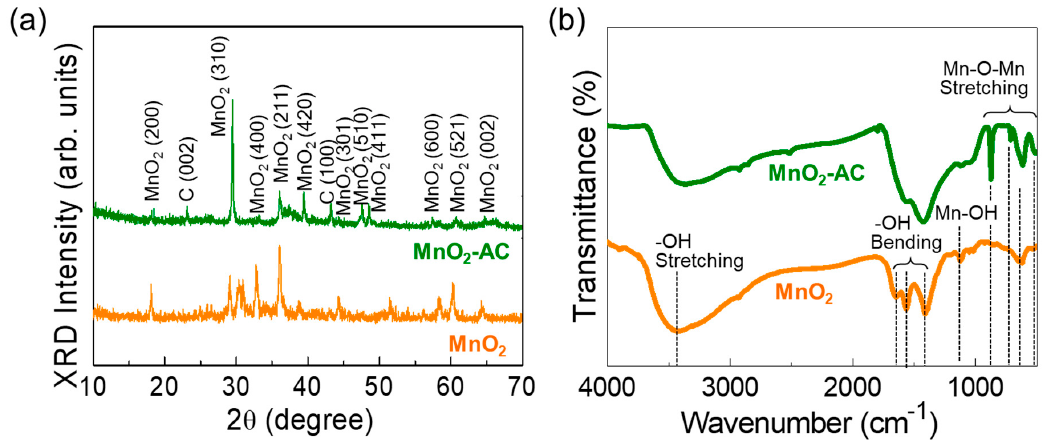
Figure 3. ( a ) XRD patterns and ( b ) FTIR spectra of MnO 2 nanoparticles and MnO 2 -AC nanocomposites.